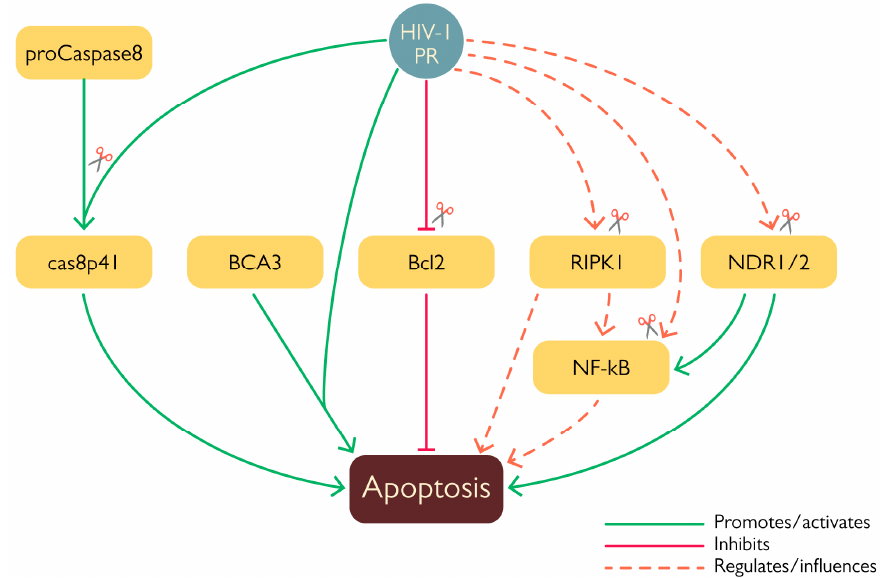
Figure 7. HIV-1 PR modulation of apoptosis via cleavage or interaction with cellular factors. The viral protease is able to cleave several proteins involved in apoptosis regulation. By cleaving procaspase 8 into its cas8p41 fragment, the viral enzyme is able to promote programmed cell death. Likewise, cleavage and consequent inhibition of Bcl-2 also contributes to apoptosis activation. Interestingly, the non-proteolytic interaction between PR and BCA3 was also shown to increase apoptosis. Furthermore, HIV-1 PR cleaves several other proteins involved in the activation and regulation of apoptosis. In these cases, the consequences of their cleavage are not as clear but they fit into the complex scheme of HIV-1-dependent regulation of programmed cell death.